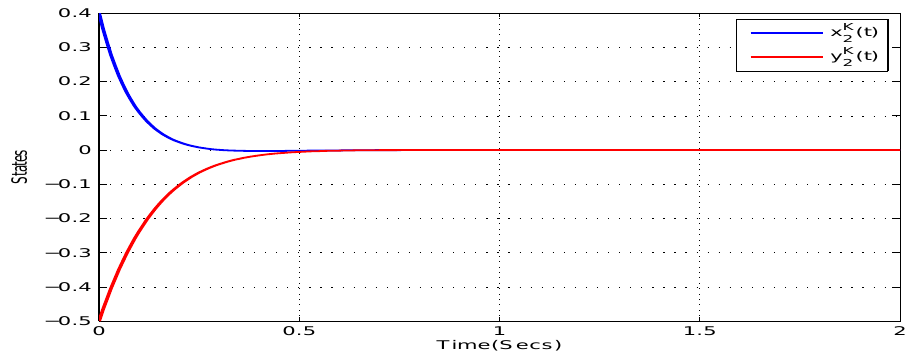
( t ) , y K ( t ) in Example 2 2